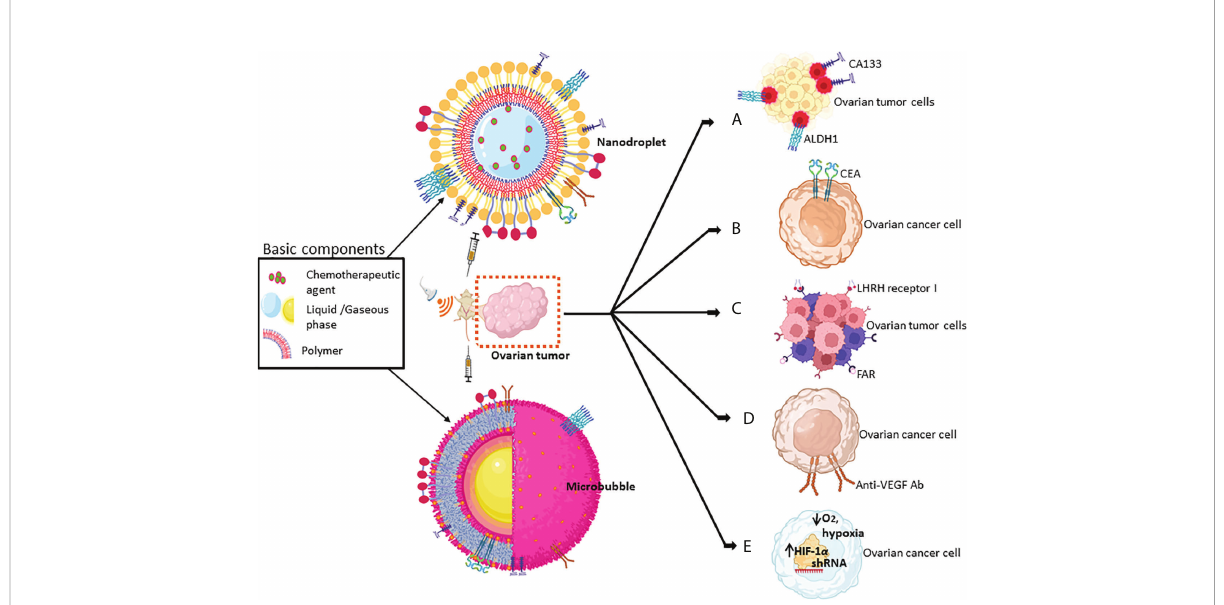
FIGURE 2 Schematic of the key strategies for targeting various biomolecules of ovarian tumors by MBs or nanodroplets mediated by US-based technologies. Chemical drugs/biologics that have been used for targeting biomolecules include (A) CD133+ or ALDH1+ in ovarian cancer stem cells (in red); (B) CEA, the surface marker of OCs; (C) LHRH receptor I and FAR; (D) the angiogenic growth factor, VEGF; and (E) the hypoxic responsive protein HIF-1 a (refer to Table 3 for more